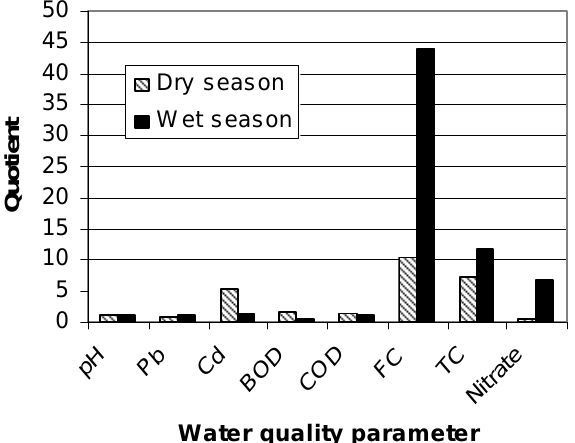
Figure 3 : Quotient factors for water quality parameters in wells near solid waste dumpsite relative to the wells in residential